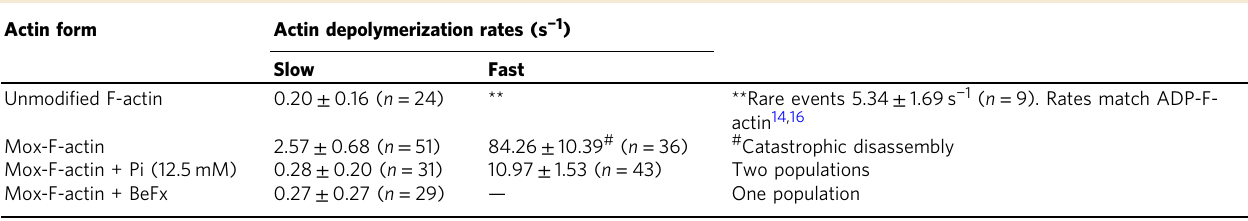
Table 1 Depolymerization of unoxidized and Mical-oxidized F-actin in the absence of actin monomers Actin